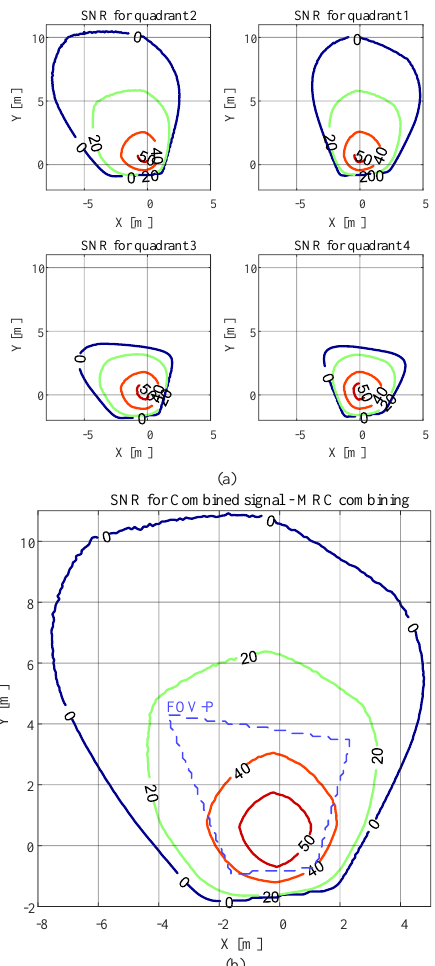
Figure 10. SNR in dB versus QADA location in an area equipped with a single transmitter with m = 1 and with the receiver held at an angle (tilted by 20 ◦ along the axis and 5 ◦ along the axis) with a FOV-C of 63.4 ◦ for ( a ) each quadrant; ( b ) the combined signal using